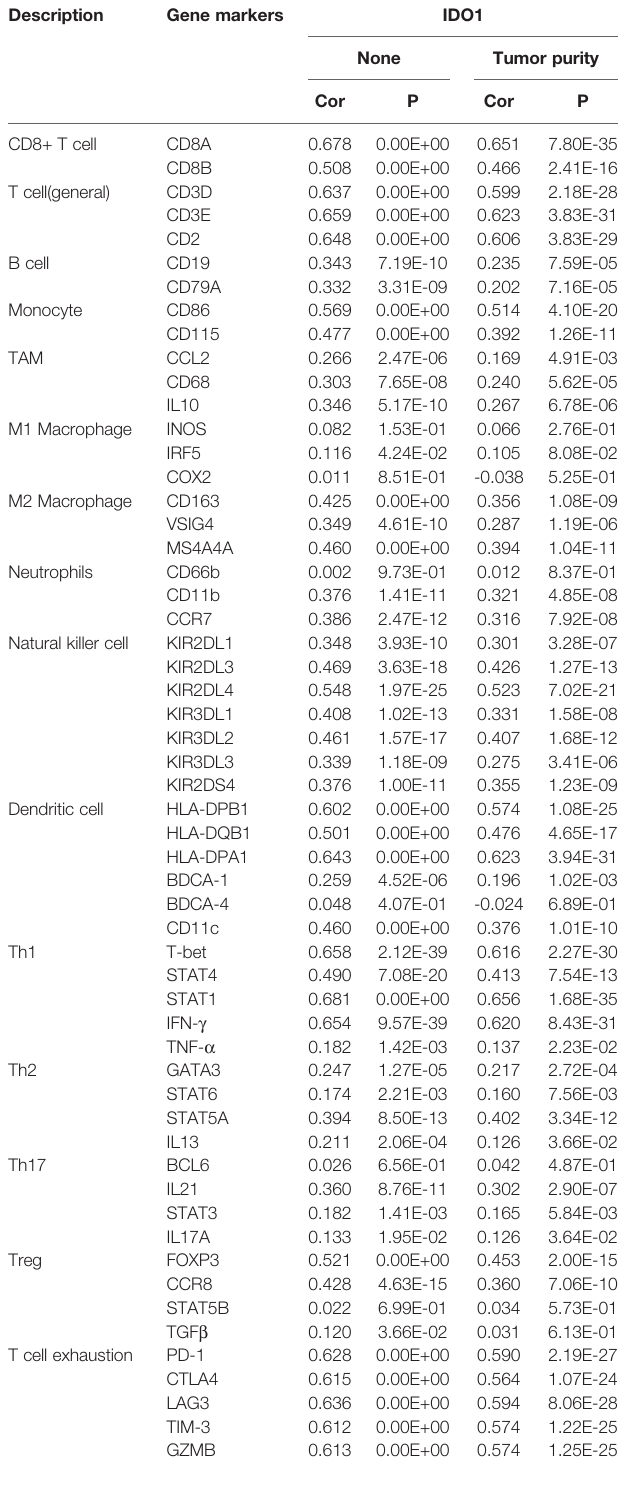
TABLE 1 | Correlation analysis between IDO1 and markers of immune cells in TIMER. Description Gene